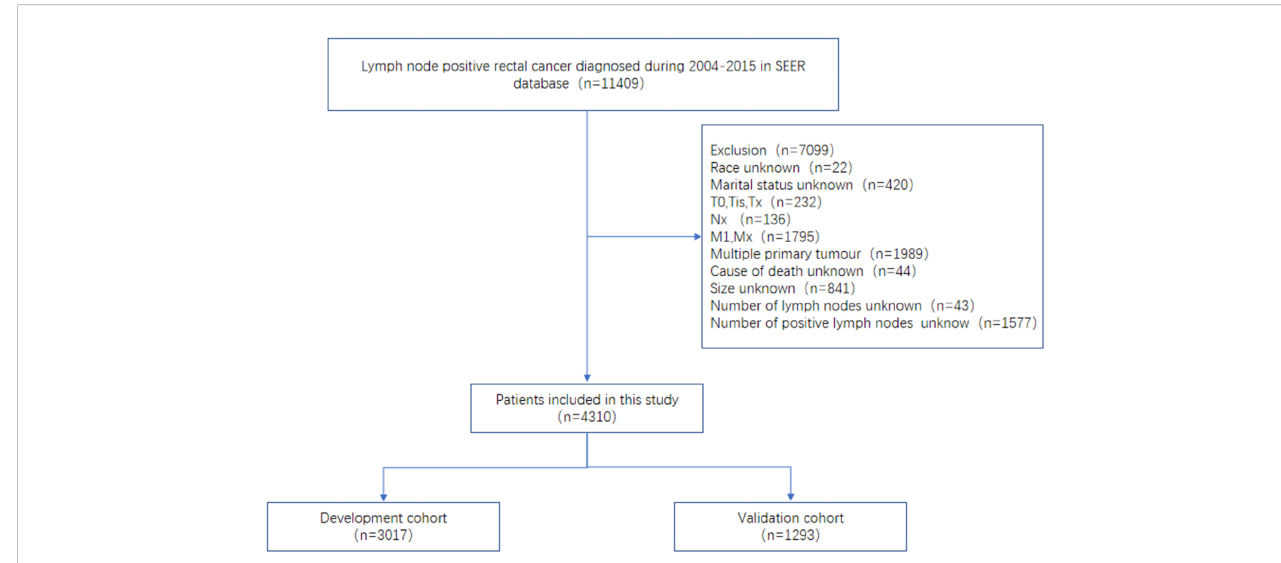
FIGURE 1 Flow diagram of the rectal cancer patients with development and validation